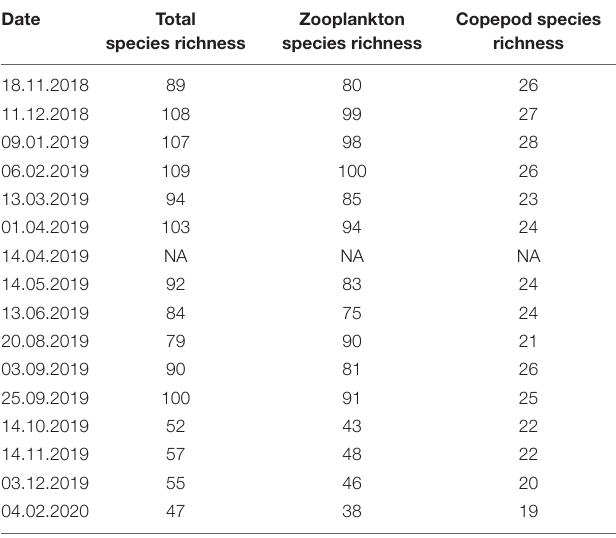
TABLE 3 | Species richness in Ramfjord based on metabarcoding analysis.